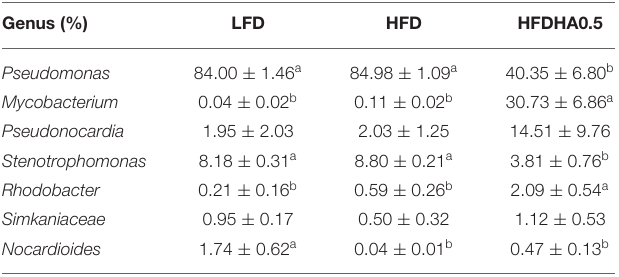
TABLE 7 | Diversity index of gut bacteria of zebrafish fed with the LFD, HFD or HFDHA0.5 for 2 weeks. LFD HFD HFDHA0.5